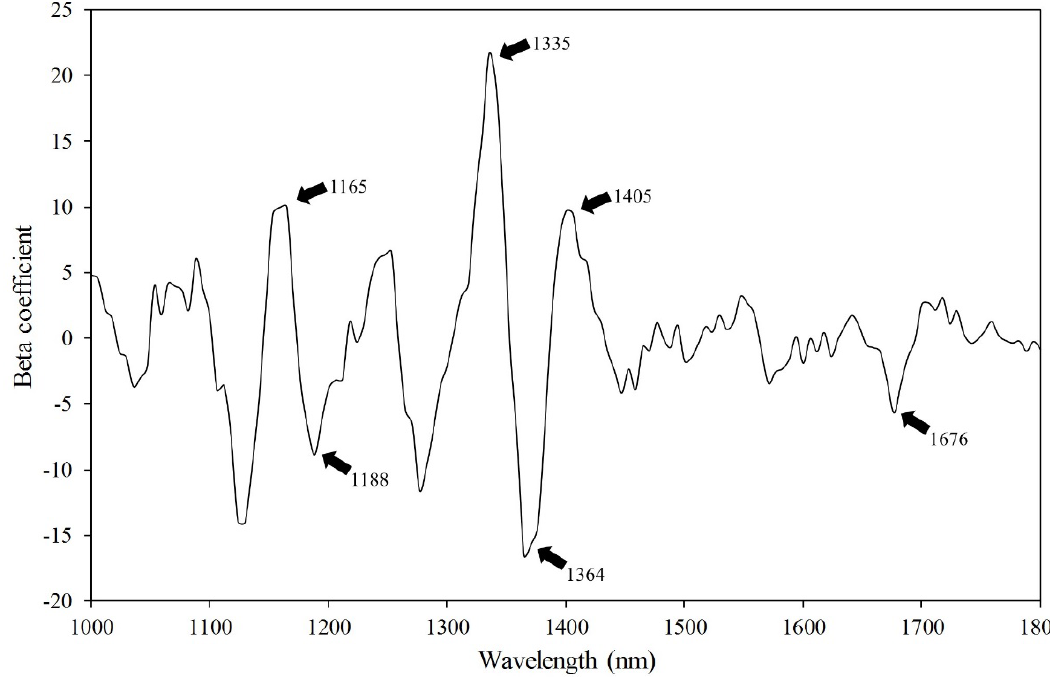
Figure 5. Beta coefficient of the PLS-DA model using the original (raw) full wavelengths (B 0 = 0.4533).